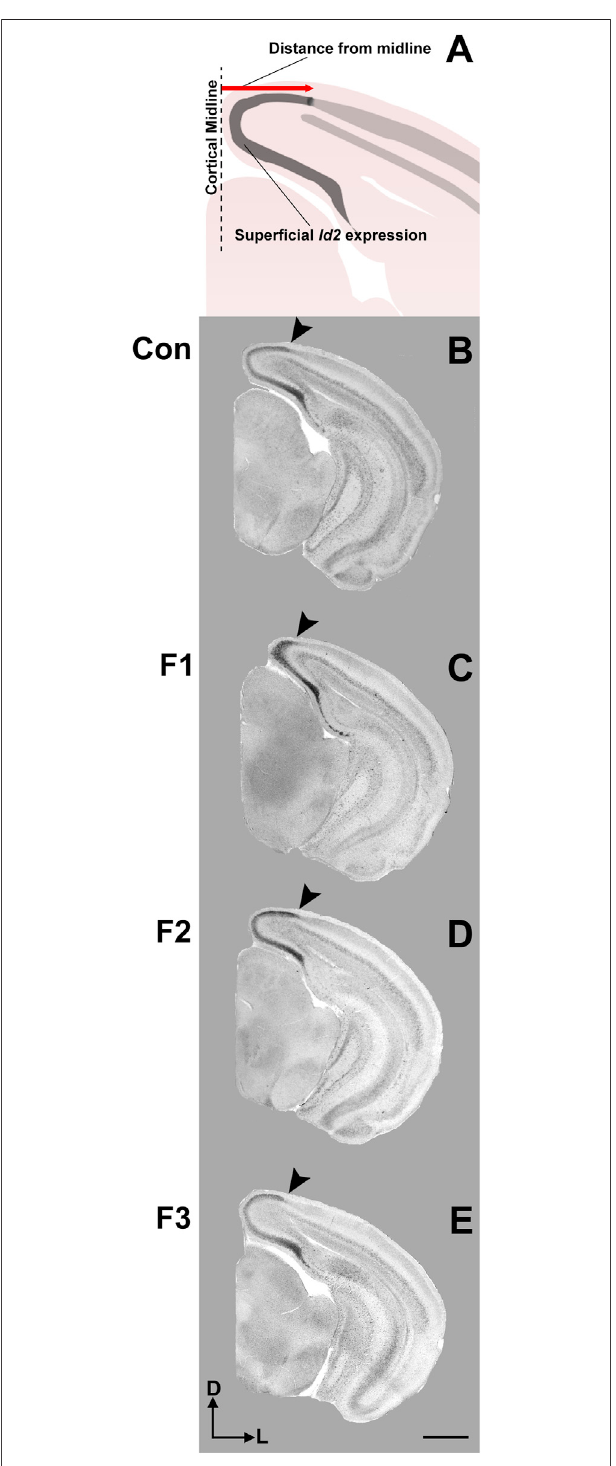
FIGURE 6 | Cortical Id2 phenotype in F1 mice. (A) Line drawing of Id2 ROI and measurement technique. Individual representative cases are displayedforcontrolmice(male, B ),F1mice(male, C ),F2mice(female, D )and F3 mice (female, E ). Arrows depict the lateral limit of Id2 expression, demonstrating a PrEE-induced phenotype in F1 mice. Coronal images of in